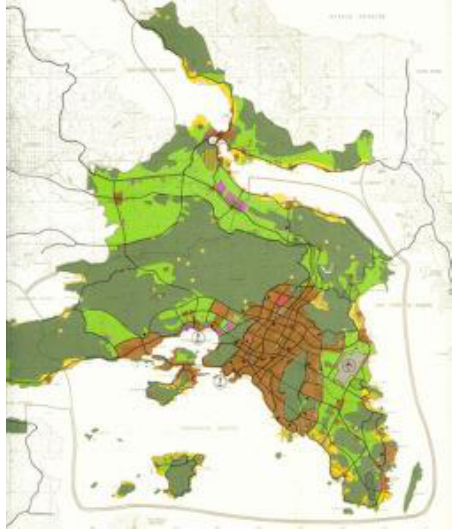
Fig. 1. Spatial Plan and Program for the Capital City, Doxiadis Associates